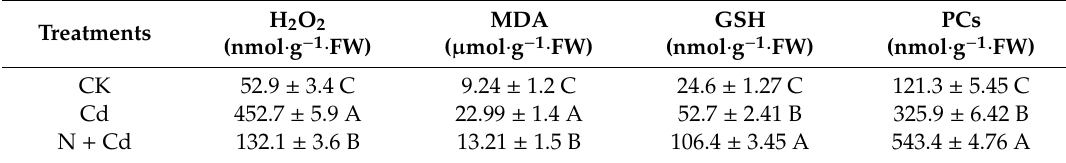
Table 4. E ff ects of cadmium supplementation with nitrogen on H 2 O 2 , MDA, GSH and